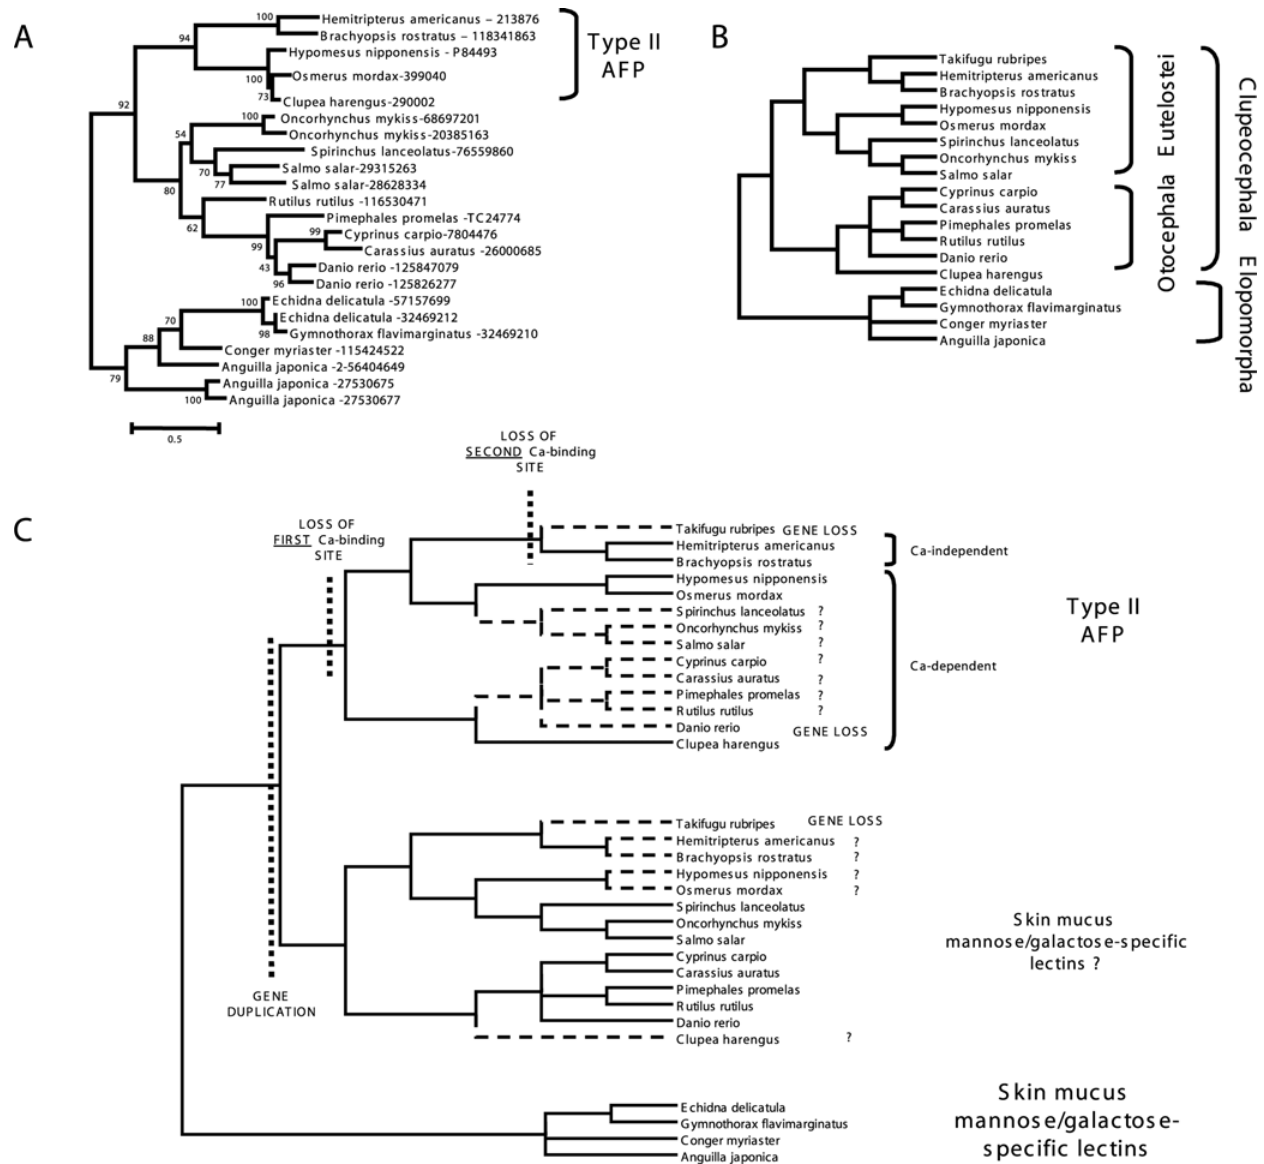
Figure 3. Phylogenetic and evolutionary analyses of type II AFPs. (A) Maximum likelihood (ML) phylogenetic tree of type II AFPs and representatives of the most closely related fish skin mucus lectins. The values on the nodes represent the bootstrap support for the individual branches. (B) Phylogenetic tree of Teleostei reproduced based on Lundberg, John G. 2006. Teleostei. Version 18 August 2006 (temporary). http:// tolweb.org/Teleostei/15054/2006.08.18 in The Tree of Life Web Project, http://tolweb.org/ and classification from the NCBI Taxonomy